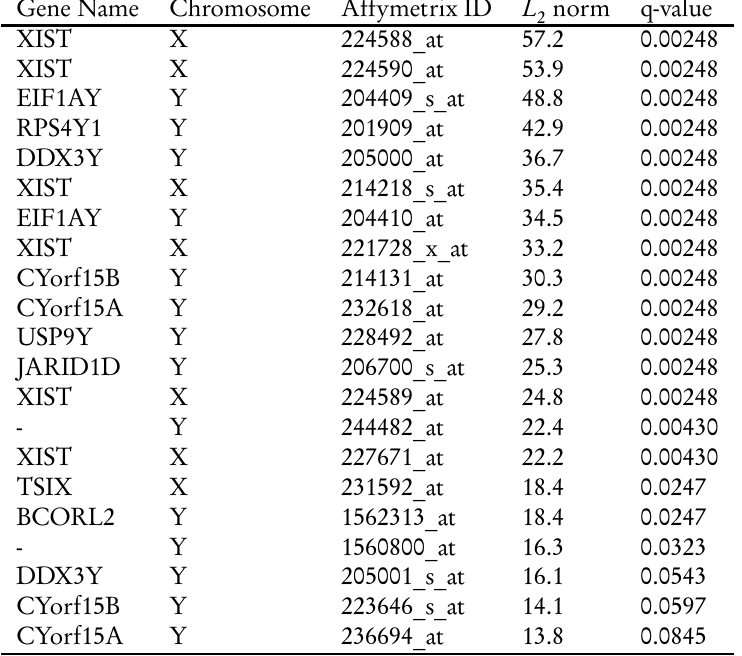
21 probes found to have a significant gender-effect Aside from XIST, all of these probes can be found on the Y-chromosome. Q-value indicates the corresponding false discovery rate (FDR) if a particular gene is taken to be the cut-off between significant and